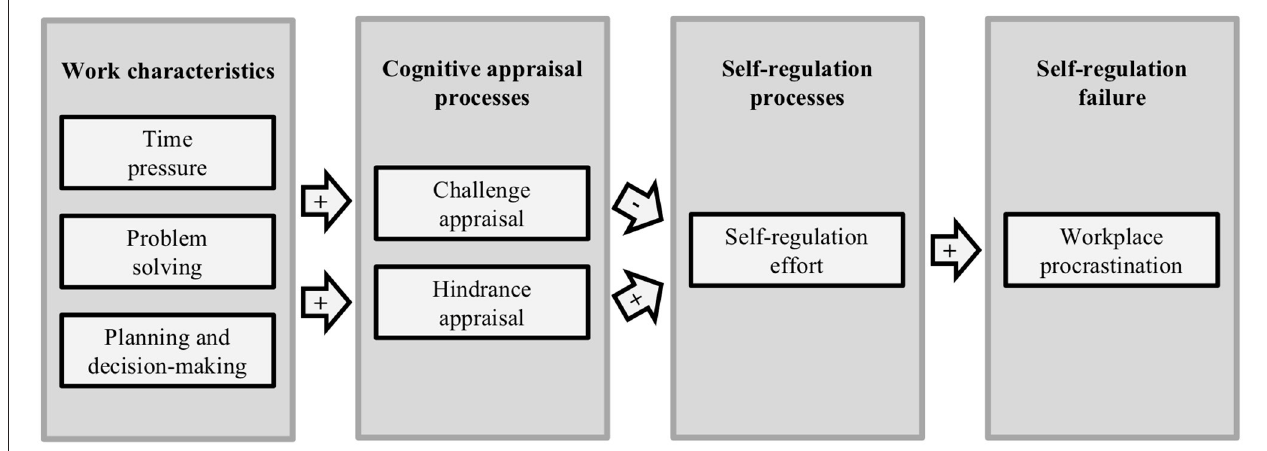
FIGURE 1 | Conceptual model of the study regarding serial within-person effects of work characteristics on workplace procrastination via cognitive appraisals and self-regulation